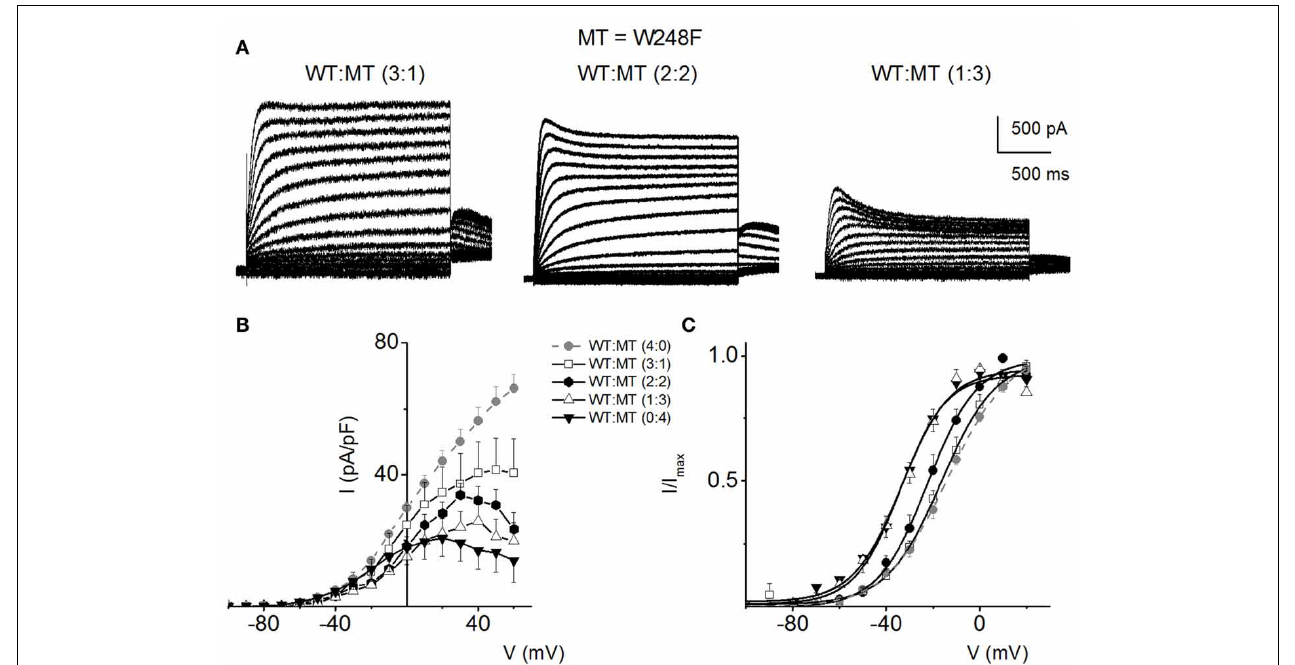
FIGURE 5 | Co-expression of JLNS mutant W248F and wild-type (WT) hKv7.1 channels. (A) An example of outward current traces recorded from a holding potential of -80 to 50mV using a voltage increment of 10mV in depolarizing and hyperpolarizing step voltages. Current traces recorded CHO cells, which were transfected with WT-hKv7.1:MT-W248F (3:1, left panel), (2:2, middle panel), and (1:3, right panel). (B) Group data of current density-voltage curves (mean ± SD) for co-expression of WT-hKv7.1 alone ( ) with WT-hKv7.1:MT-W248F (3:1, (cid:7) ), (2:2, ), (1:3, (cid:6) ) and (0:4, (cid:2) ). In contrast to the WT channel-alone outward currents, co-expression of the WT and MT, as well as the MT channel by itself, yielded currents which showed robust inward rectification at depolarizing voltages greater than 0mV step (data